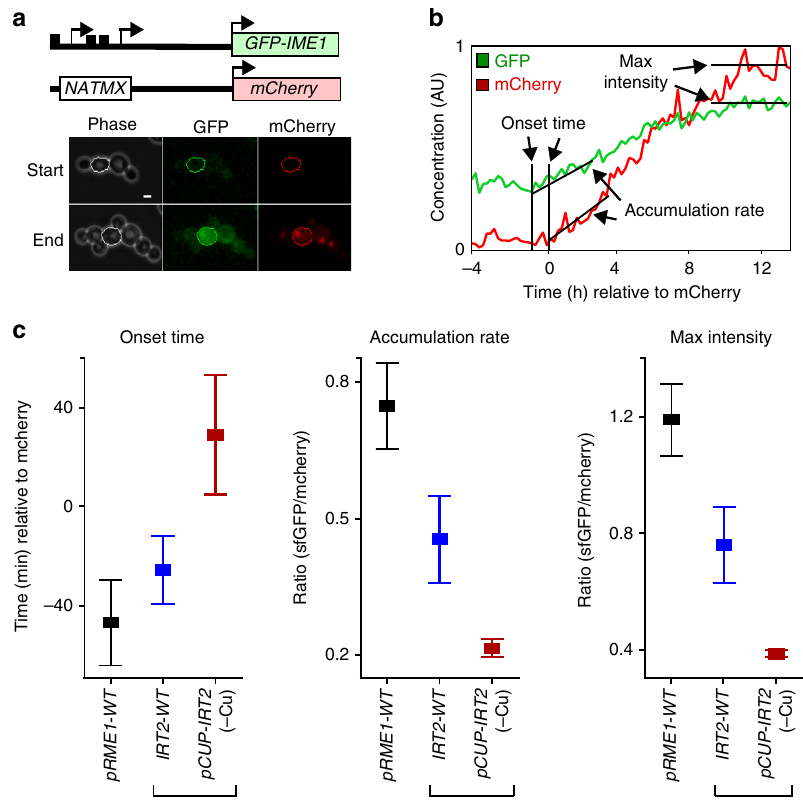
Fig. 5 Single-cell analysis of the IME1 , IRT2 , and IRT1 feedback cascade. a Schematic overview of IME1 locus used for time-lapse microscopy (top). Diploid cells were heterozygous for the IME1 locus: one copy of GFP fused to N-terminus of IME1 ( pIME1-GFP-IME1 ) and one copy expressing the IME1 promoter fused to mCherry lacking the IRT2 sequence ( pIME1- Δ irt2-mCherry ). Cells were grown to log phase in synthetic complete media loaded into a micro fl uidic device, induced to enter meiosis and imaged for up till 50 h (see supplemental information for details). Example images of phase, GFP, and mCherry of a single cell taken at start and end of a time-lapse experiment (bottom). The scale bar in right bottom corner represents 3.2 μ m. b Example of traces of a single cell. GFP and mCherry fl uorescence signals were monitored and overall signals were scaled (see supplemental information for details). The graph also displays the time of initiation of expression (onset time), the rate of accumulation, and maximum levels (max intensity) of pIME1-GFP-IME1 and pIME1- Δ irt2-mCherry . c Summary of data obtained from time-lapse microscopy experiments. All strains harbored one copy of pIME1-GFP-IME1 and one copy of pIME1- Δ irt2-mCherry , combined with either wild-type RME1 (FW4843), pRME1 - Δ aa1 (FW4844), or pRME1 - Δ aa1 / pCUP-IRT2 (FW5051). Cells were imaged and GFP and mCherry fl uorescence signals were quanti fi ed. Mean onset times, rate of accumulation, and max intensity were determined. The means ± SEM of n = 58 (FW4843), n = 88 (FW4844), and n = 64 (FW5051) cells are shown. All pairwise differences, except between FW4843 and FW4844 (left panel only), are statistically signi fi cant; p < 0.001 (Kolmogorov – Smirnov